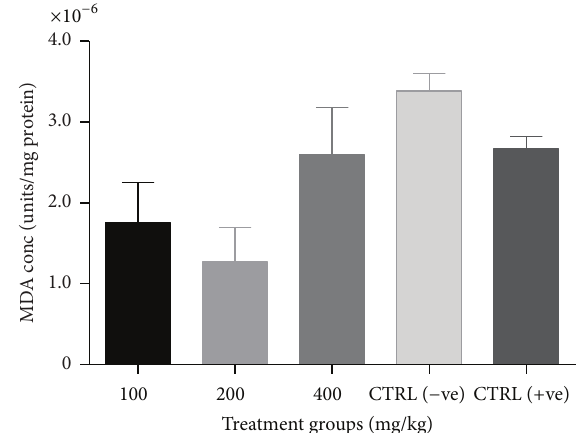
Figure 5: Effect of combined extracts of Azadirachta indica and Khaya senegalensis on lipid peroxidation (malondialdehyde, MDA) of chickens infected with Eimeria